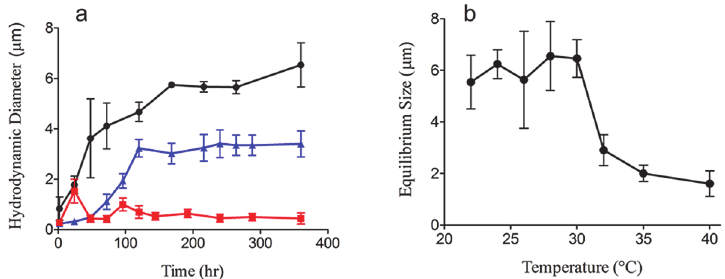
Fig 1. Microgel assembly / dispersion are temperature dependent. 1-a. Microgel assembly rate and equilibrium size decreases with increased temperature. Samples were incubated at 22 ˚ C (black circles), 32 ˚ C (blue triangles) and 35 ˚ C (red squares) for 24 hours, then stored in the dark at 22 ˚ C for the remainder of the experiment. Assembly was measured using dynamic laser scattering at 22 ˚ C. Each data point represents (mean ± SD) of six measurements made in each of six replicate samples. Data highlight that short-term temperature exposure above 35 ˚ C confers significant DOM assembly loss with no obvious recovery. 1-b. Microgel dispersion depends on temperature variation. Self-assembled microgels (size ~ 6 μ m) were incubated at various temperatures (from 22 ˚ C to 40 ˚ C) for 24 hours. The equilibrium microgel sizes were monitored with dynamic laser scattering spectroscopy. Each data point represents six replicate samples. Non-linear temperature responses of microgels were observed — particularly for microgels incubated at temperatures above 32 ˚ C, which showed a marked size decrease.